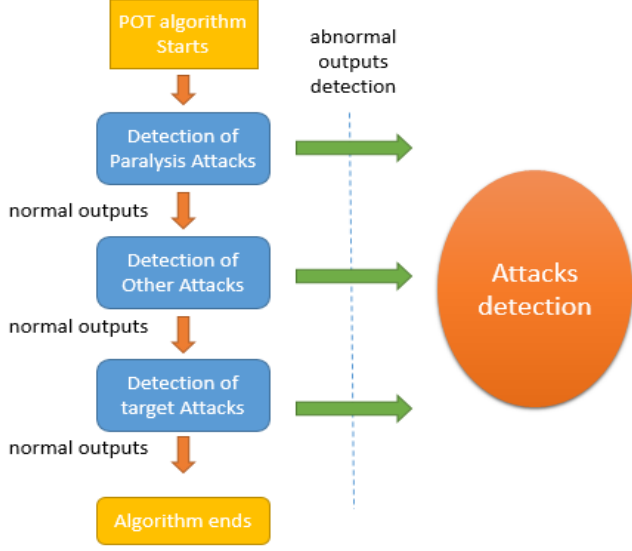
Figure 2. Flowchart of proposed IDA detection algorithm.